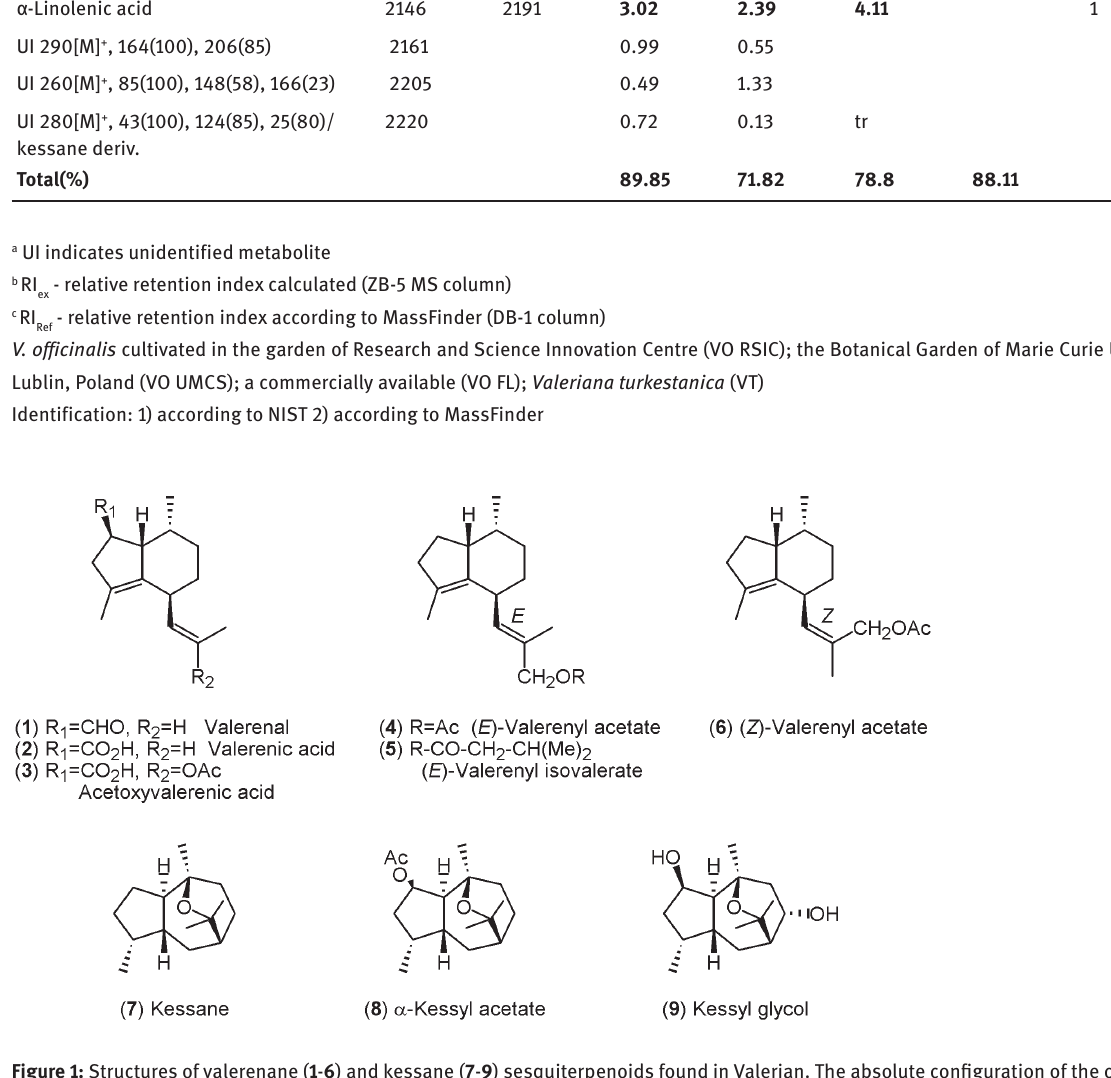
Figure 1: Structures of valerenane ( 1 - 6 ) and kessane ( 7 - 9 ) sesquiterpenoids found in Valerian. The absolute configuration of the compounds is inferred from the published literature [21,